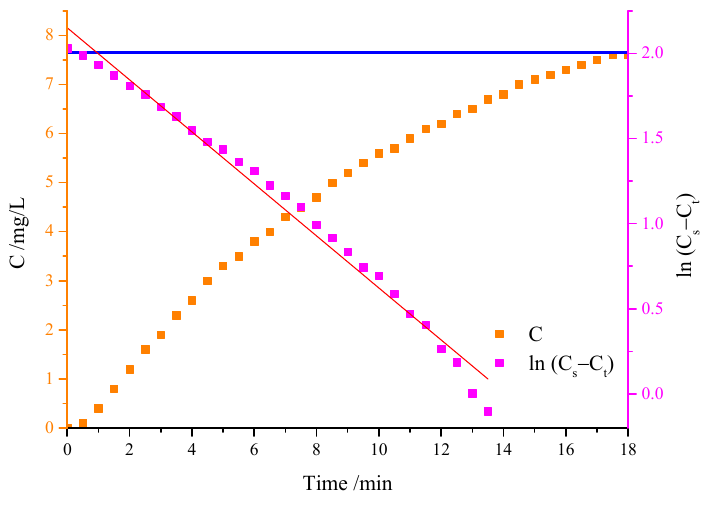
Figure 3. Dissolved oxygen concentration curve and fitting results.